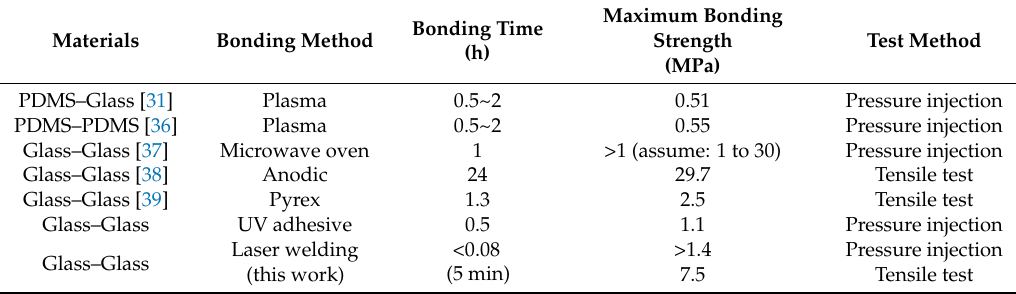
Table 1. Comparison of glass bonding method.